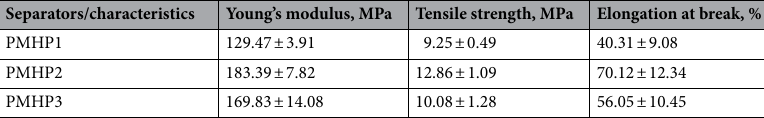
Table 3. Mechanical characteristics of PMHP membranes.